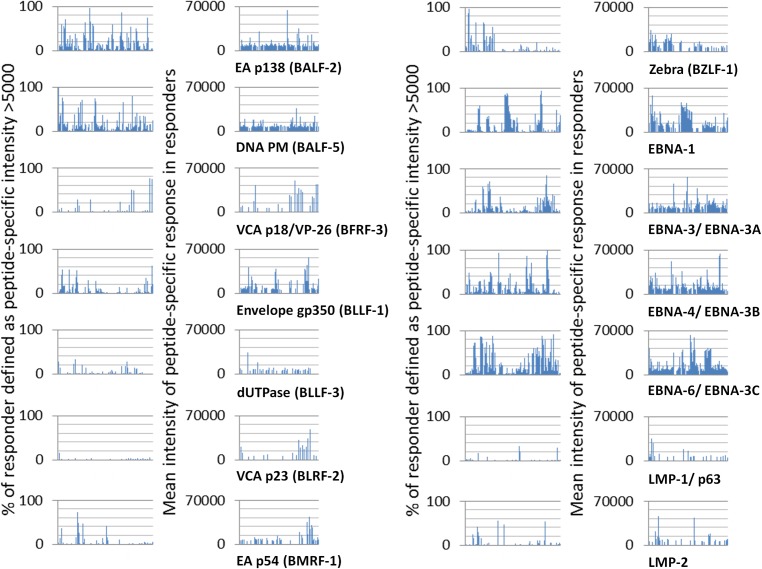
Seroarray analysis of IgG antibody reactivity against 15-mer EBV peptides which cover 14 EBV proteins with sequences of EBV type I (B-95.8) in 50 healthy donors.IgG responses of each sample against each peptide are depicted. Responses are defined as a signal intensity above 5,000. In the left graph the % of samples with a response against each single peptide of the indicated proteins are shown. The right graph shows the mean intensity of these IgG responses (defined as a signal intensity above 5,000) against the single peptides. EA- early antigen; PM- polymerase; VCA- viral capsid antigen; gp- glycoprotein.